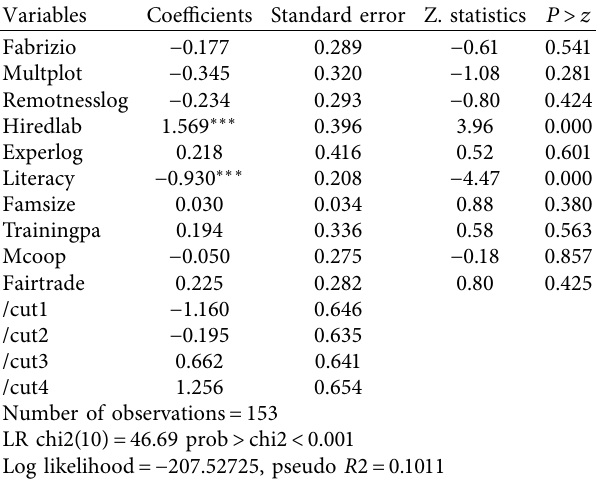
Table 4: Ordered probit estimates of the factors influencing the number of SFEPs